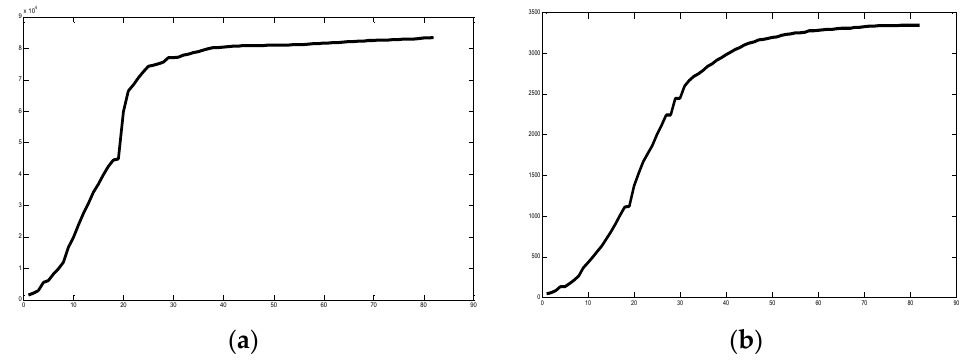
Figure 9. ( a ) Plot of confirmed cases for China, ( b ) plot of death cases for China (2 January 2020 to